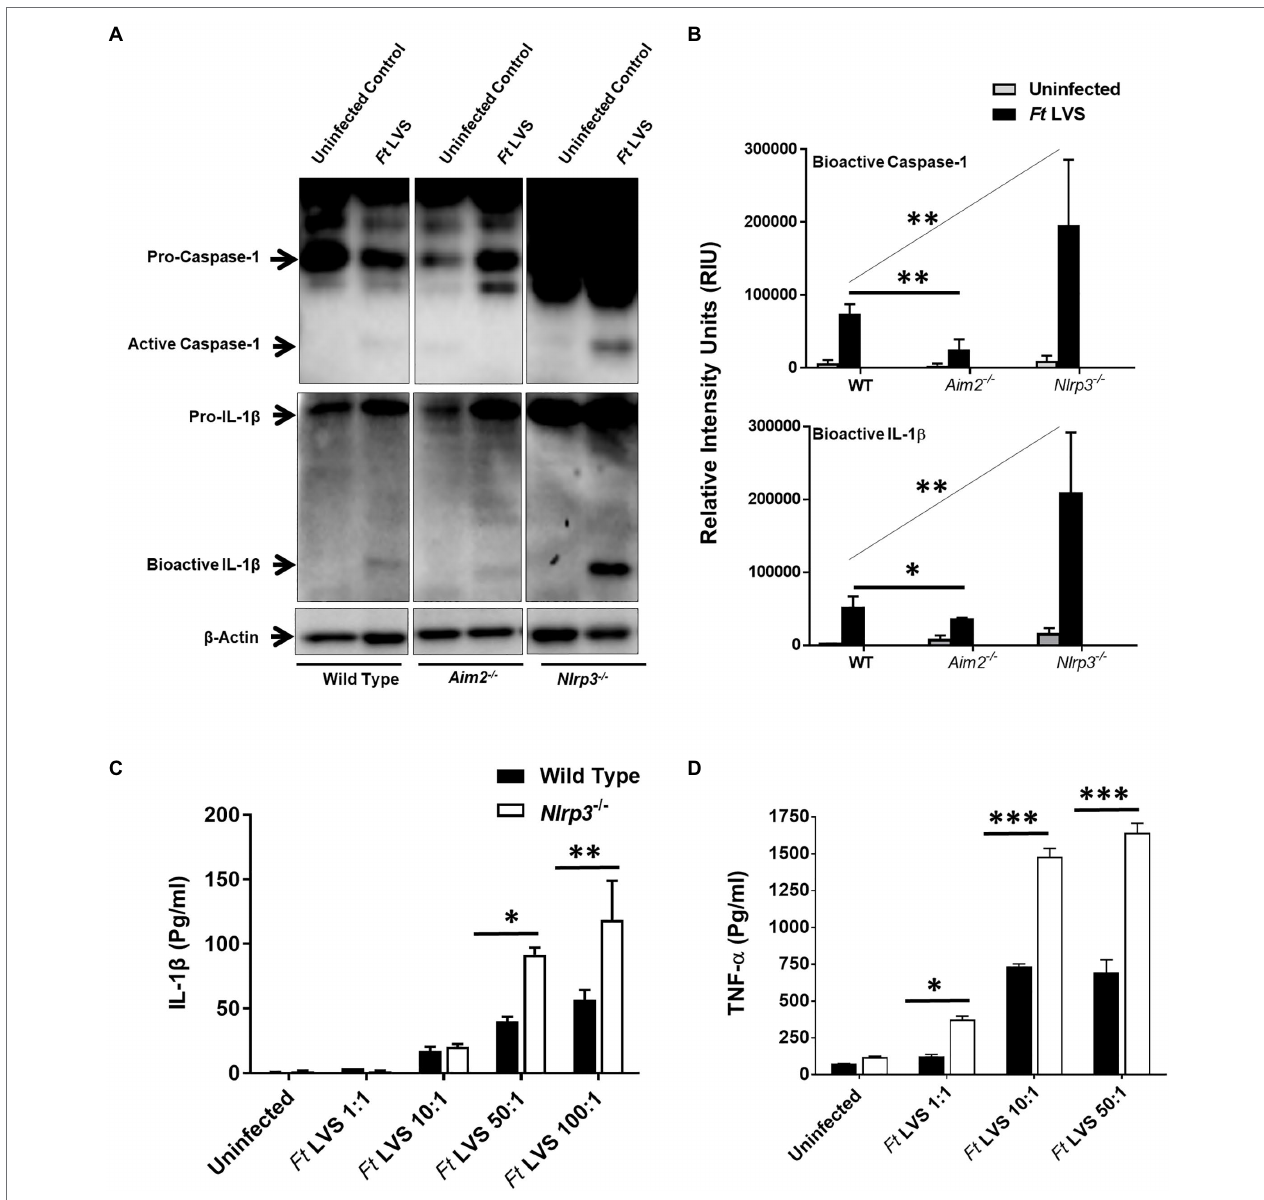
FIGURE 1 | Nlrp3 dampens pro-inflammatory cytokine response. (A) Wild type, Aim2 − / − and Nlrp3 − / − macrophages were infected with Francisella tularensis ( Ft ) live vaccine strain (LVS) at an multiplicity of infection (MOI) of 100. The cell lysates were prepared 24 h post-infection and western blot analysis was performed to determine levels of bioactive caspase1 and IL-1 β . The western blot images are representative of three independent experiments. β -actin was used as a loading control. The uncropped version of (A) is shown in Supplementary Figure S1 . (B) The quantification of the bands ( n = 3 blots) is shown and expressed as relative intensity units (RIU). (C,D) The wild-type and the Nlrp3 − / − macrophages were infected with the indicated MOI of Ft LVS and treated with gentamicin to kill extracellular and adherent bacteria after 2 h of infection and the infection with intracellular bacteria was allowed to proceed for 22 h. The IL-1 β (C) and TNF- α (D) levels were measured in the culture supernatants after 24 h post-infection. The results are representative of three independent experiments. The data in B–D were analyzed by ANOVA with the Tukey-Kramer test, and a p- value of 0.05 or less was considered significant. * p < 0.05; ** p < 0.01; *** p <